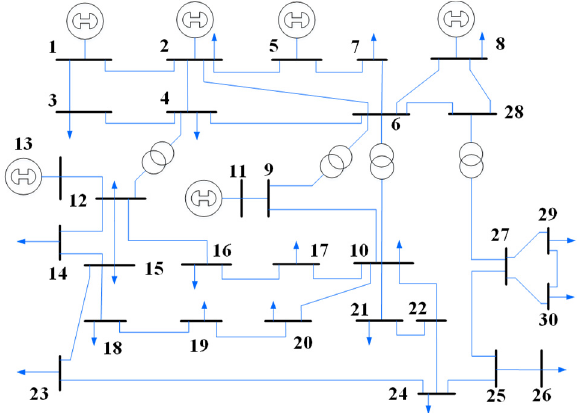
Figure 6. Diagram of the IEEE 30-bus system.